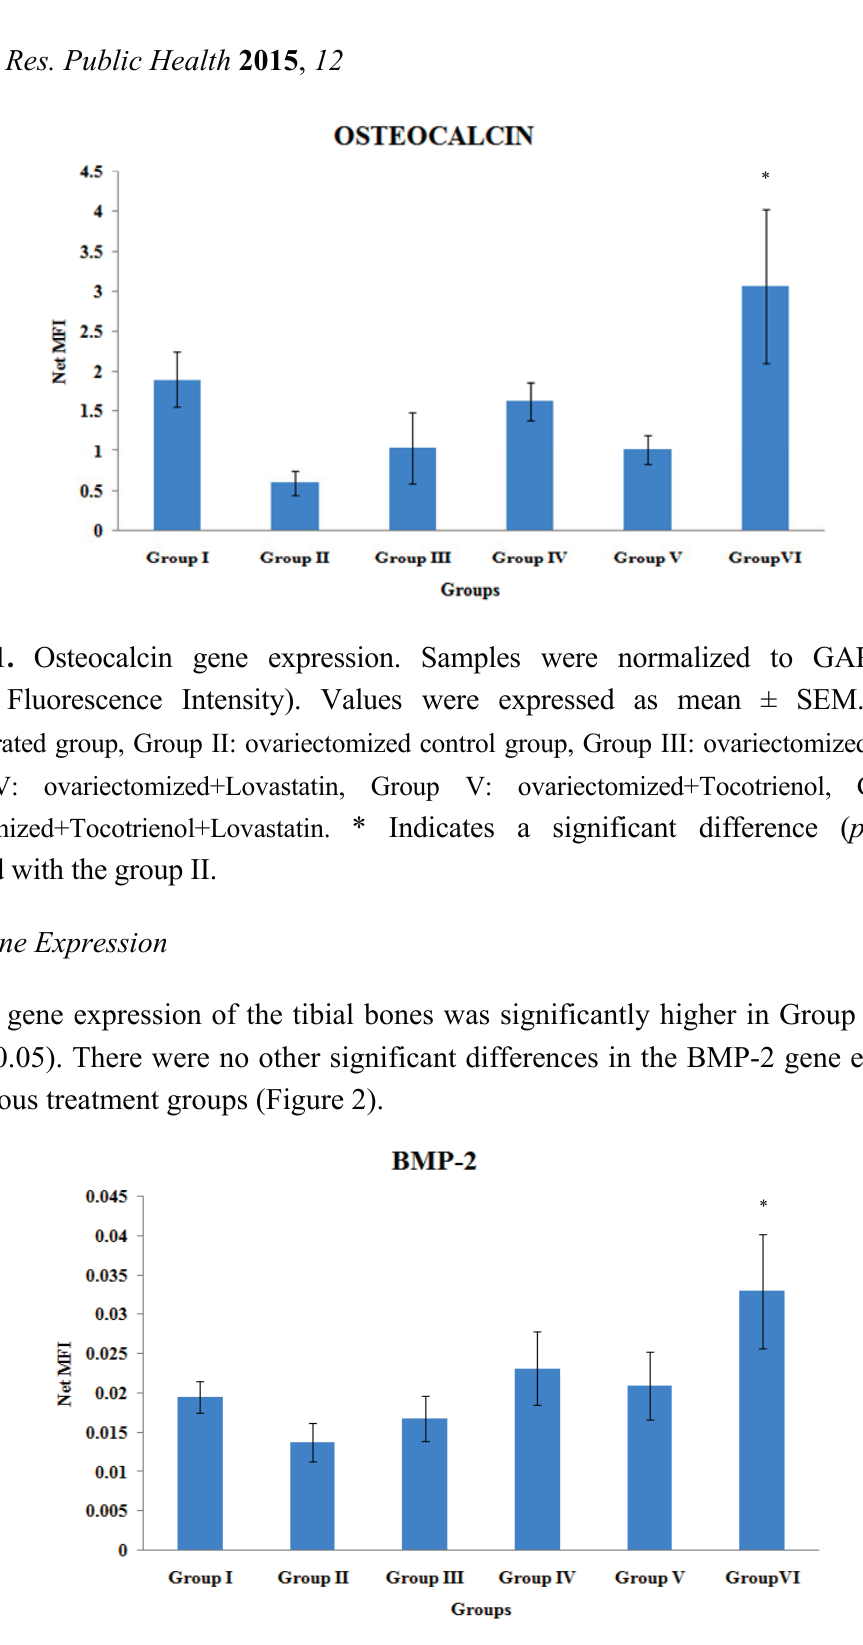
Figure 2. BMP-2 Gene Expression. Samples were normalized to GAPDH MFI (Median Fluorescence Intensity). Values were expressed as mean ± SEM. Group I: sham-operated group, Group II: ovariectomized control group, Group III: ovariectomized+Estrogen, Group IV: ovariectomized+Lovastatin, Group V: ovariectomized+Tocotrienol, Group VI: ovariectomized+Tocotrienol+Lovastatin. * Indicates a significant difference ( p < 0.05) compared with the group